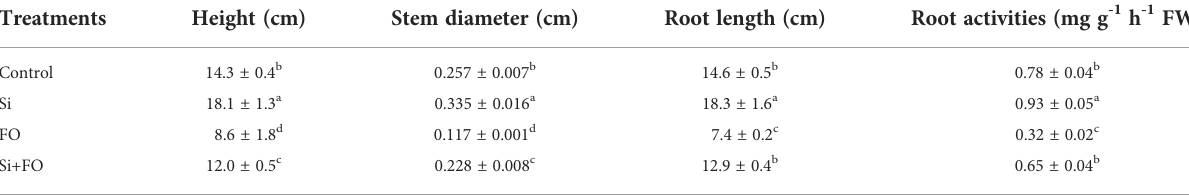
Means (± standard deviation) denoted by the different lowercase letters in each column are signi fi cantly different according to Tukey ’ s test (P ≤